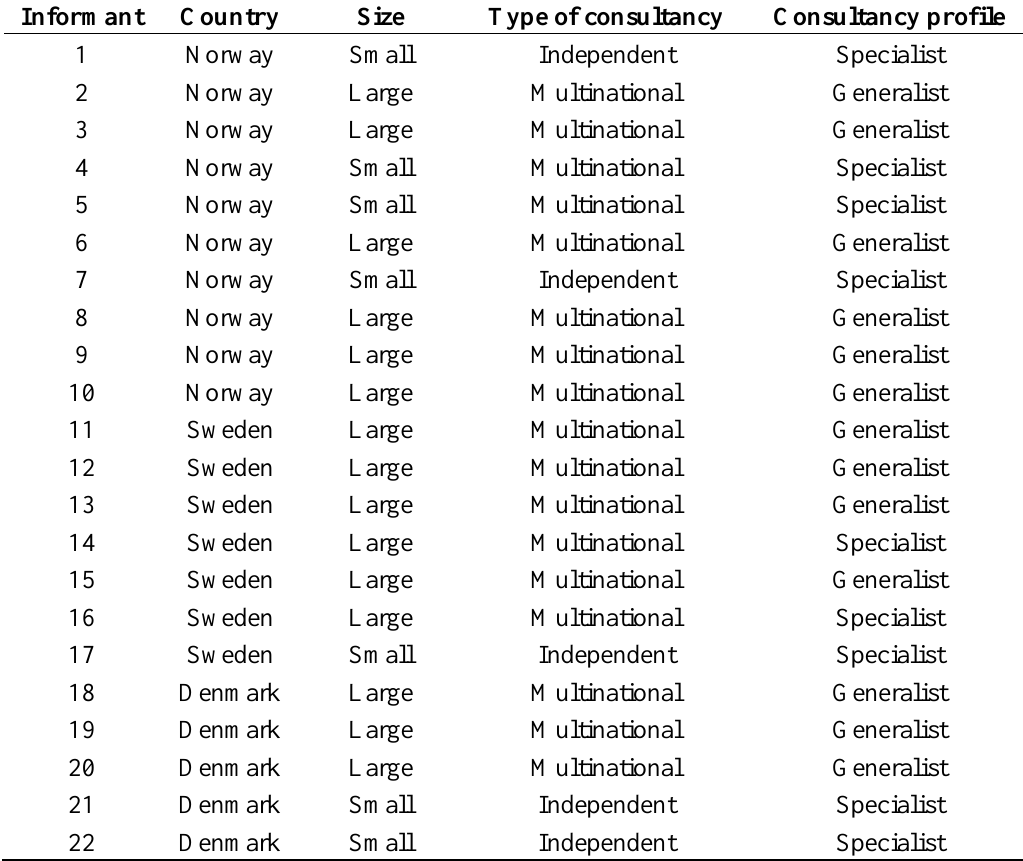
Table 3. Details about the informants in the theoretical